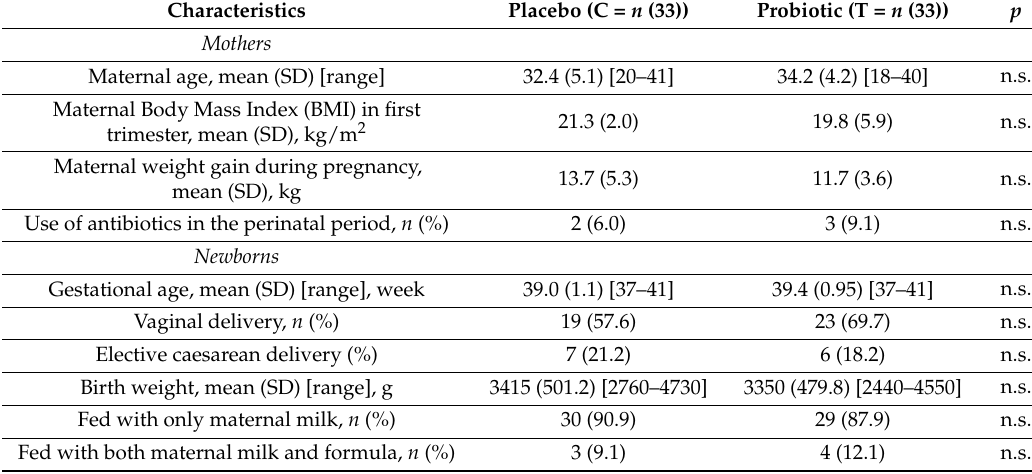
Table 1. Demographic and clinical characteristics of the study